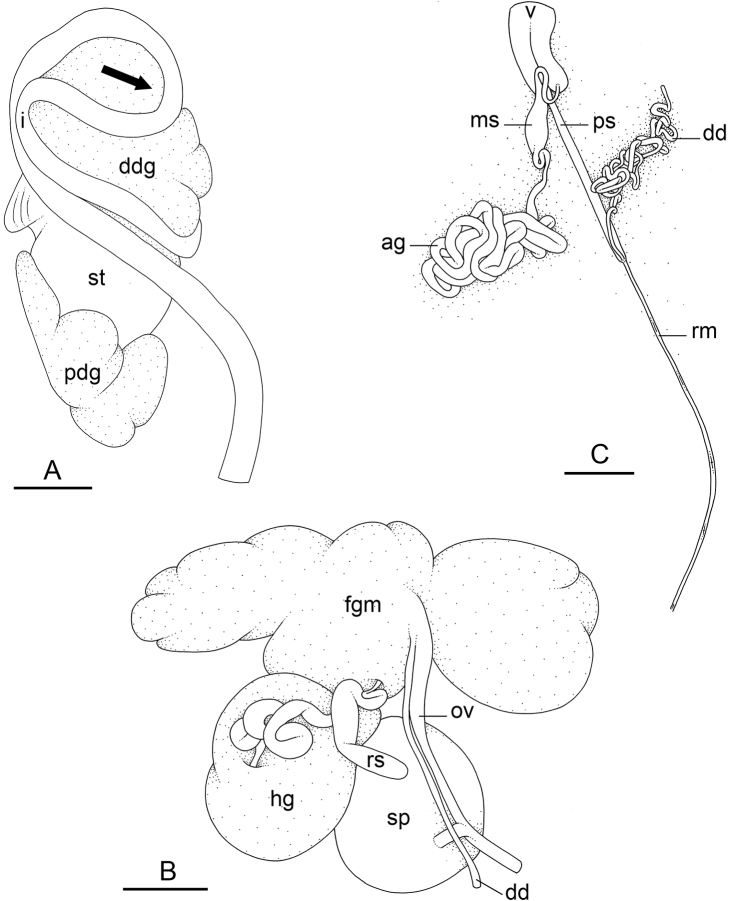
Peronia
verruculata (unit #2), Indonesia, Sumatra, [1746] (UMIZ 00178) A digestive system, dorsal view, the arrow indicates the orientation of the transitional loop B posterior, hermaphroditic (female) reproductive system C anterior, male, copulatory apparatus. Scale bars: 5 mm (A, C), 4 mm (B). Abbreviations: ag accessory penial gland, dd deferent duct, ddg dorsal digestive gland, fgm female gland mass, hg hermaphroditic gland, i intestine, ms muscular sac, ov oviduct, pdg posterior digestive gland, ps penial sheath, rm retractor muscle, rs receptaculum seminis, sp spermatheca, st stomach, v vestibule.